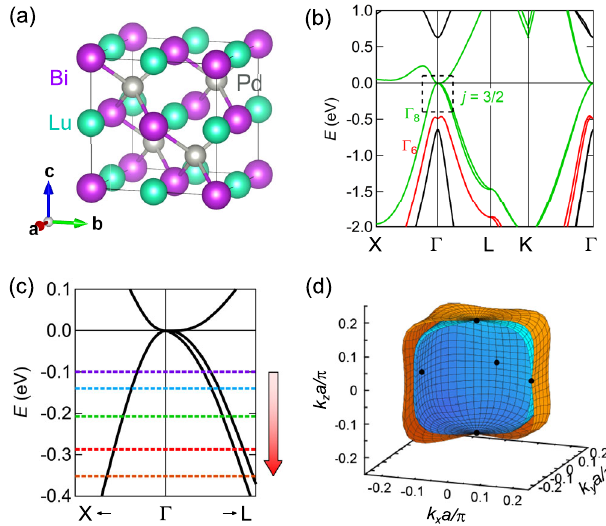
FIG. 1. Crystal and electronic structures of LuPdBi. (a) Crystal structure of the half-Heusler superconductor LuPdBi. (b) Ab initio calculations of the band structure near the Fermi energy E green and red lines are Γ 8 and Γ 6 bands, respectively. (c) Enlarged view of the calculated band structure near the Γ point [dashed square in (b)]. The horizontal purple, light-blue, green, red, and brown dashed lines represent chemical potentials obtained from the carrier densities in the pristine, 3.13, 5.28, 8.44, and 11 . 61 C = cm 2 irradiated samples, respectively. The red arrow illustrates the shift of the chemical potential caused by electron irradiation. (d) Fermi surfaces calculated from the k · p Hamil- tonian [Eq. (1)] with chemical potential u ¼ 0 . 1 eV. Orange and blue surfaces are the outer and inner spin-split FSs, respectively. Black dots represent the points where the split size of two FSs becomes